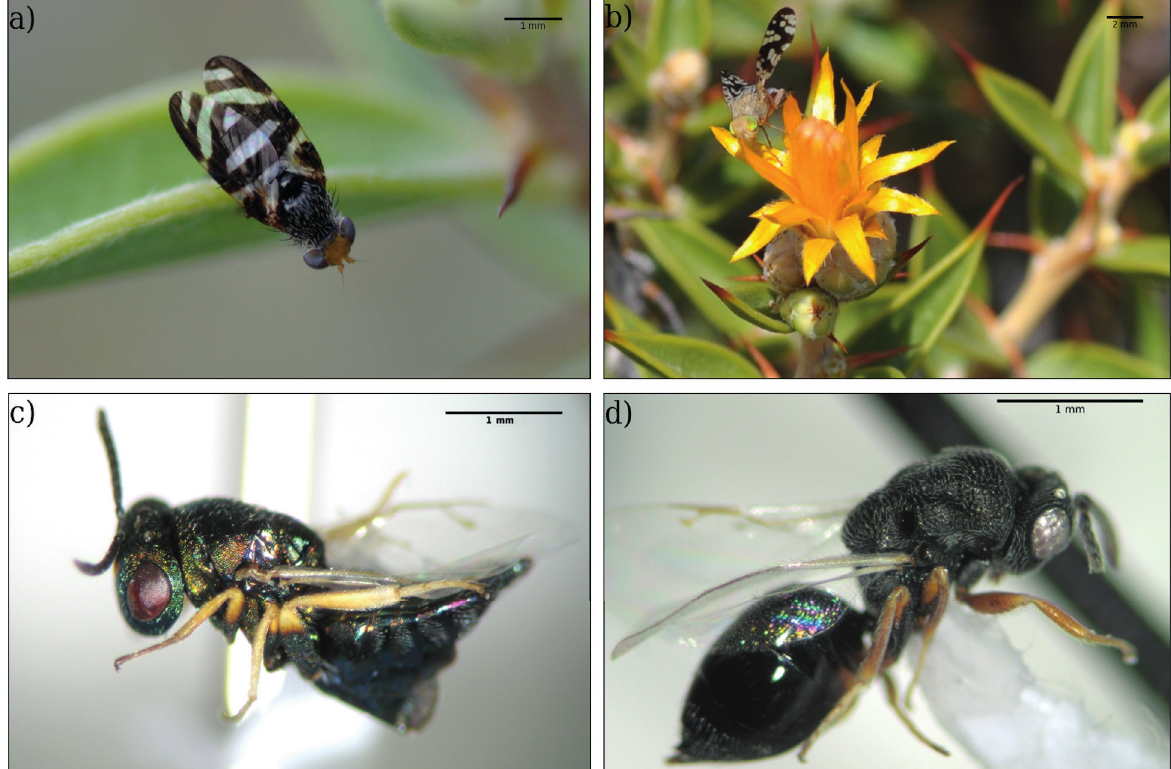
Figure 2. Cecidochares sp. on foliage of Chuquiraga avellanedae (a), Neosphaeniscus m-nigrum on capitula of C. avellanedae (b) , adult of Pteromalidae (c), and Eurytoma sp.